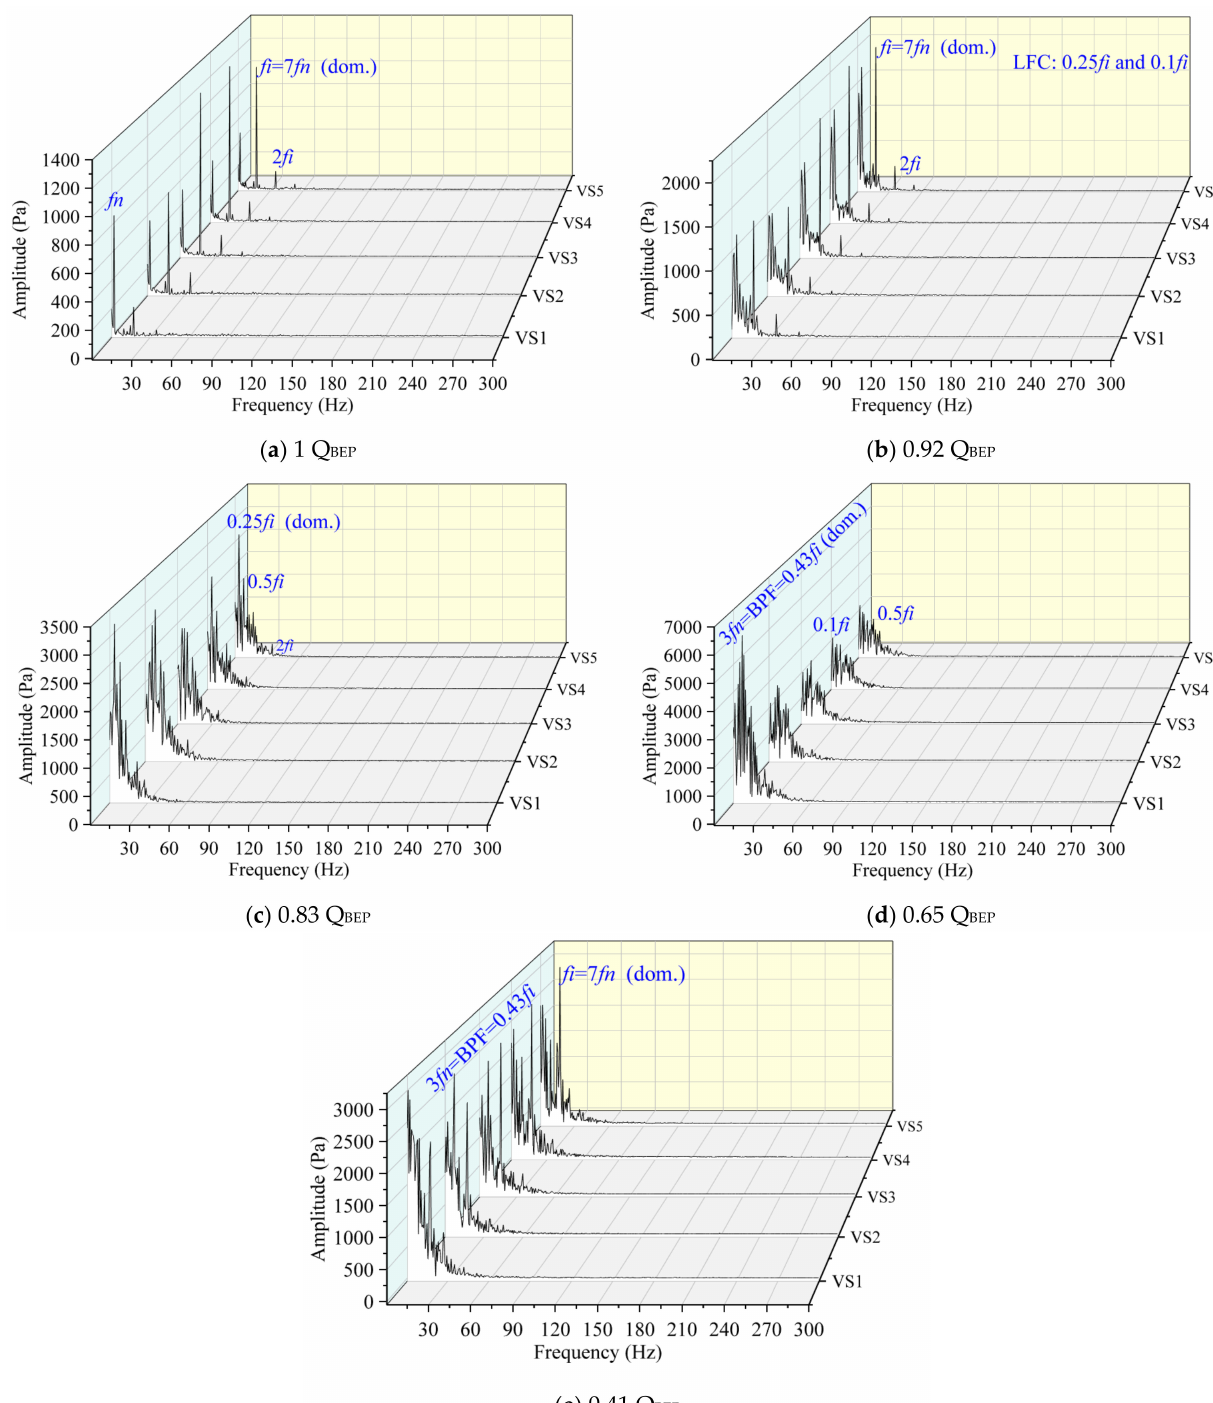
Figure 17. Frequency domain spectra of VS pressure pulsation under different flow